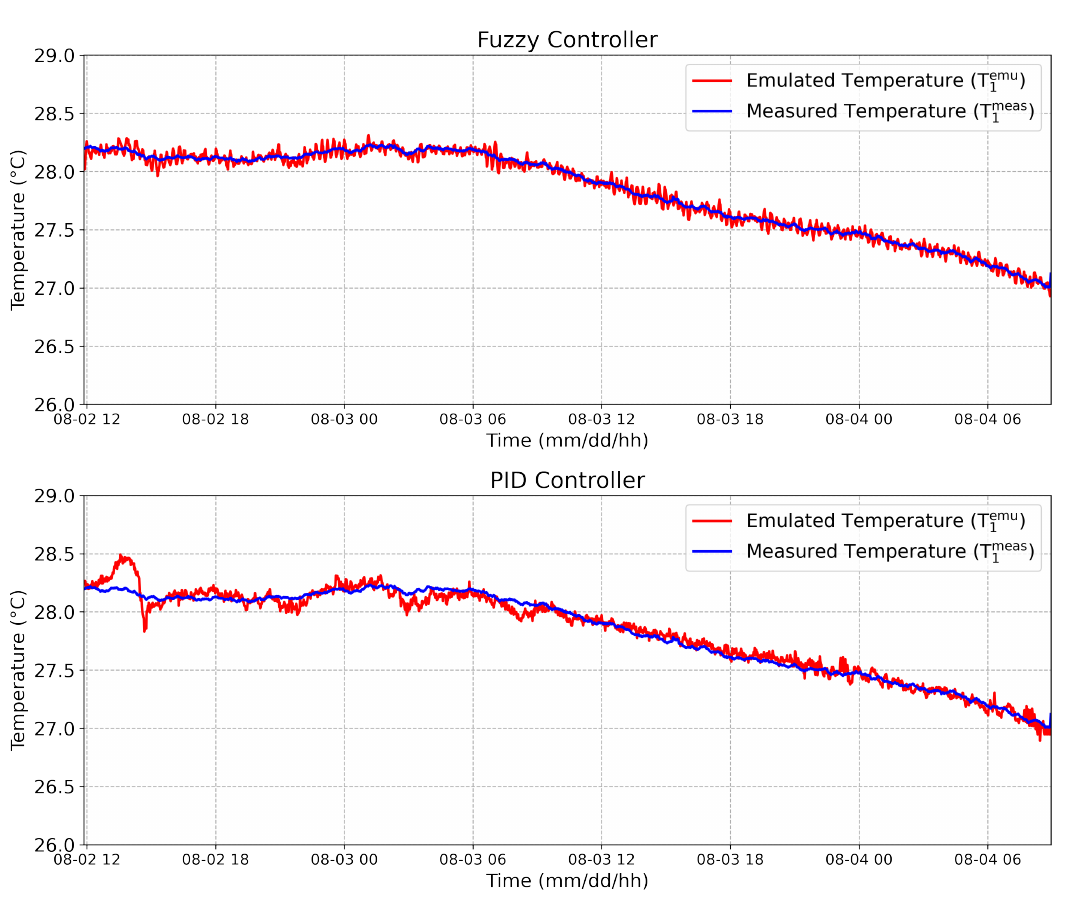
Figure 13. The 100 mm depth internal temperature: Measured temperature on the upper face T meas (blue line), and the emulated temperature on the upper face, T emu 1 Fuzzy controller and the PID controller,